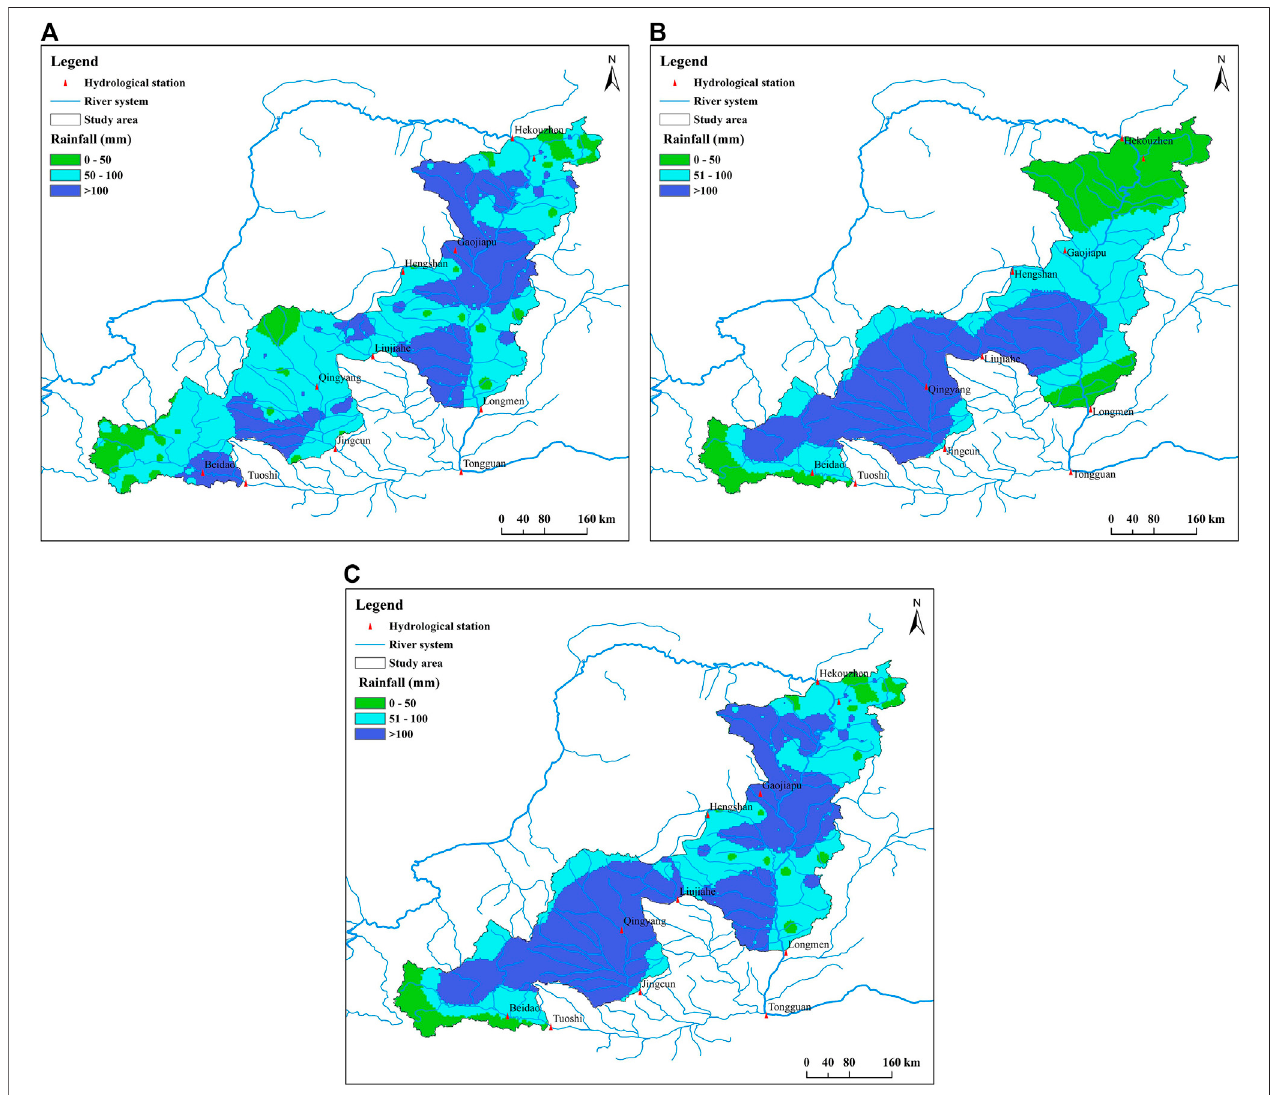
FIGURE 3 | The covered area of rainstorms for (A) scenario A, (B) scenario B and (C) scenario C in the study area.